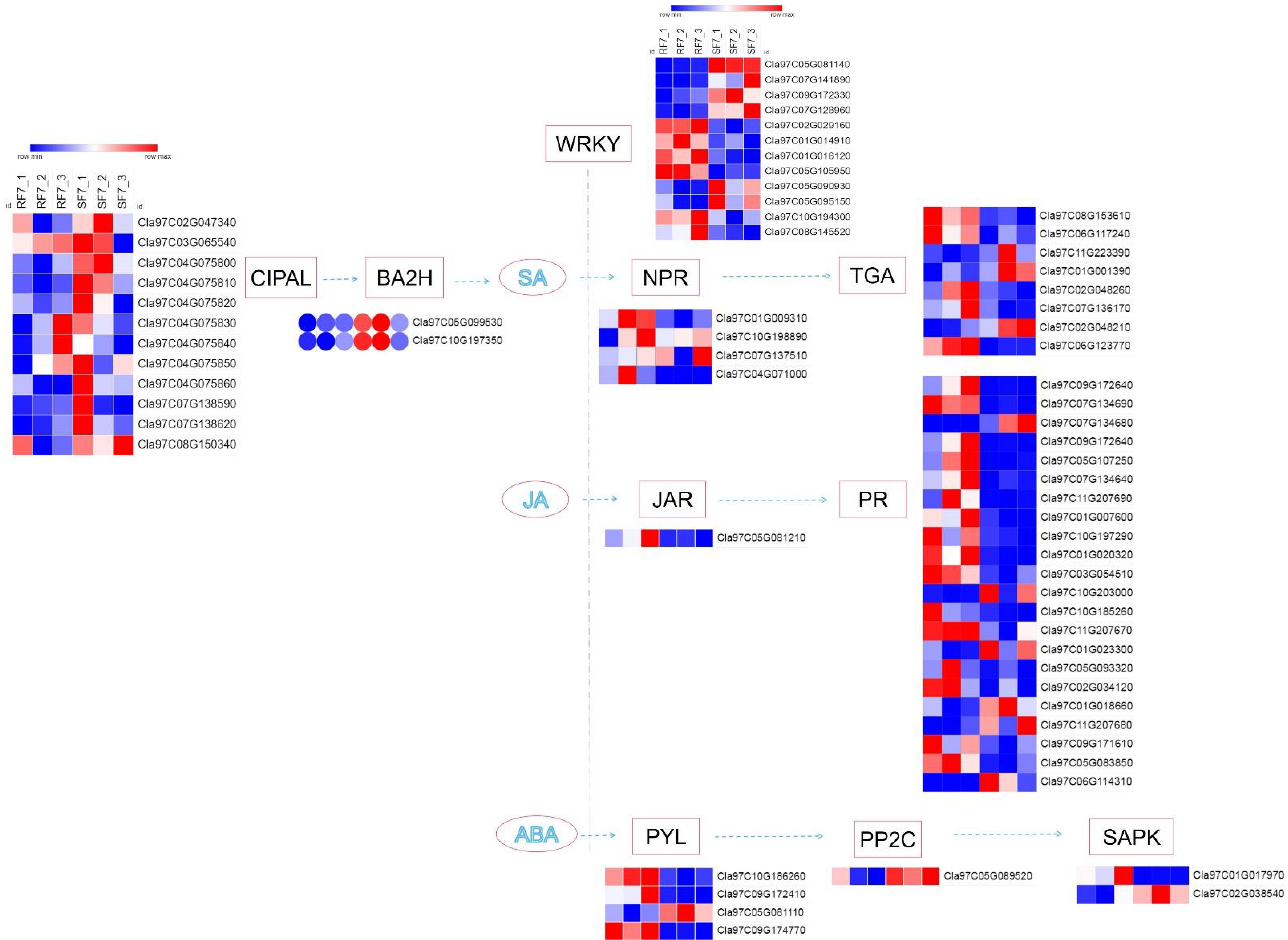
Figure 8. The schematic of SA, JA, and ABA signaling-related genes network in watermelon roots at 7 days after FON infection: Note: SF7, Susceptible cultivar + FON, 7 days post inoculation (7 dpi); RF7, Resistant cultivar + FON, 7 days post inoculation (7 dpi). Three independent replicates. Blue bands indicate low gene expression and red bands high gene expression.